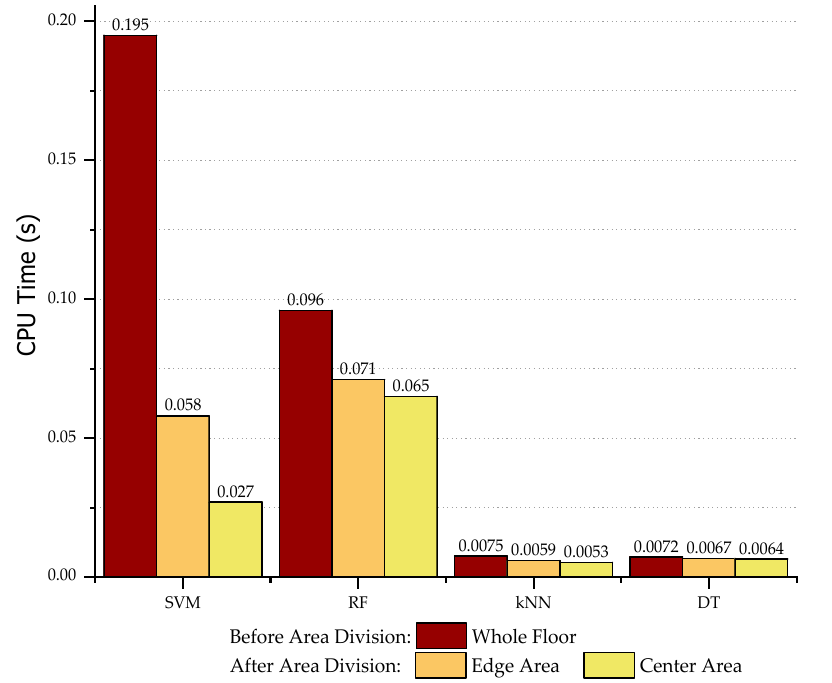
( c ) Figure 20. Mean and standard deviation of positioning errors vs. number of trees by: ( a ) whole floor, ( b ) center area, and ( c ) edge area. 5. Simulation and Results 5.1. Computational Time Comparison As depicted in Figure 21, in all four algorithms, there was a significant decrease in the computational time required after applying area division, although each algorithm showed distinct levels of improvement. To compare them with each other, the specific parameters of each algorithm were first optimized. After finding the optimal parameters, the execution time for each method was calculated. The total execution time includes the time spent on the data classification process (for area division) and the location prediction process. In Figure 21, the red column shows the total CPU time before area division, while the orange and yellow columns show the total execution time for unseen